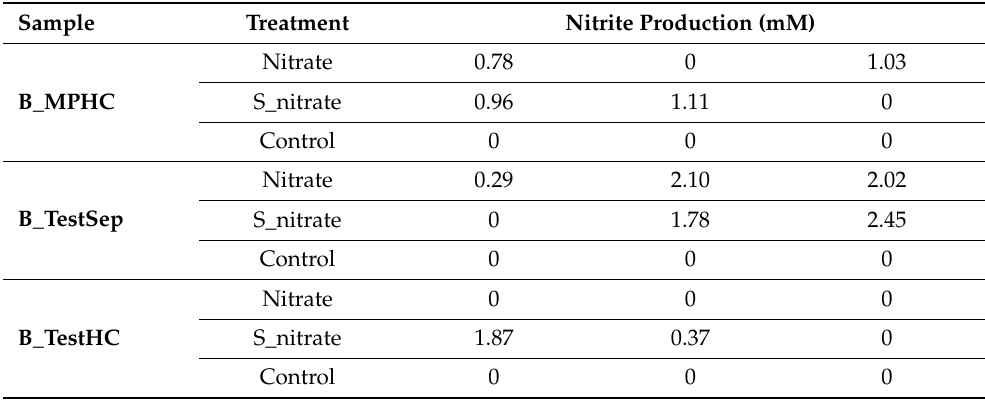
Figure 4. Percent sulfate loss over a 156-day incubation period under different treatment scenarios. Platform A samples are in orange, and Platform B samples are in blue. The data points (gray circles) indicate the values of each replicate, and the error bars indicate the mean among 3 replicates ( n = 3). The asterisks indicate the p -value (*, 0.033; **, 0.002; ***, <0.001; ns, not significant) of a treatment compared to its corresponding no-additive (NA) microcosms. ‘Control’ = sterile control. Table 2. Nitrite accumulation (mM) in nitrate-amended Platform B microcosms after a 156-day incubation